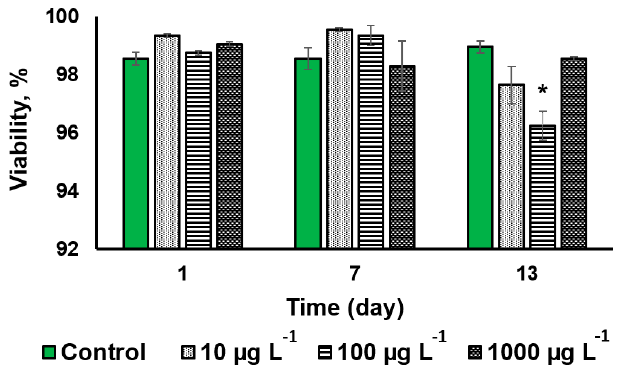
Figure 3. The analysis of the viability of Desmodesmus sp. cells incubated with CuO-NP as compared to the untreated cells. (Values significantly differing from the control are marked with an asterisk, *).